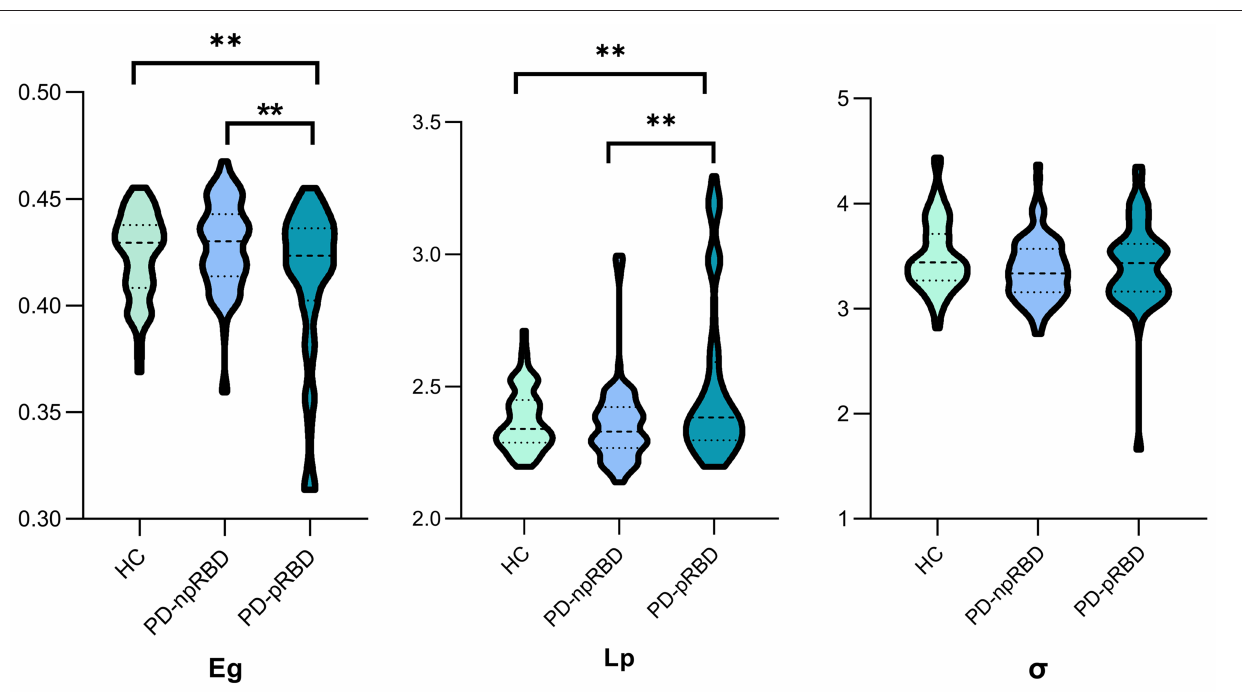
groups. Significantly different Eg (F = 5.763; P = 0.002)